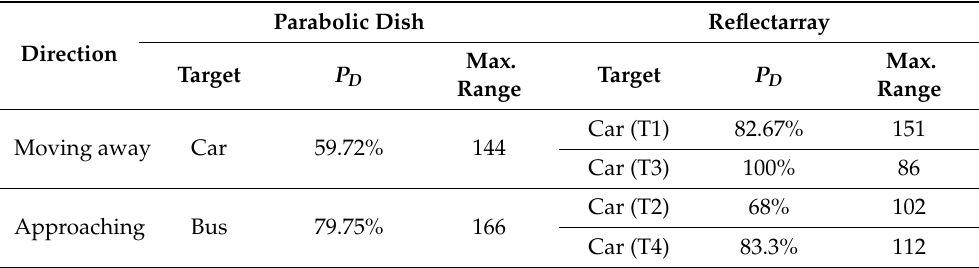
Table 2. Probability of detection of targets in scenario 1 employing the designed reflectarray and a parabolic dish as surveillance antenna. T1–T4 refers to the tracks represented in Figure 18a. Parabolic Dish Direction Max. Max.